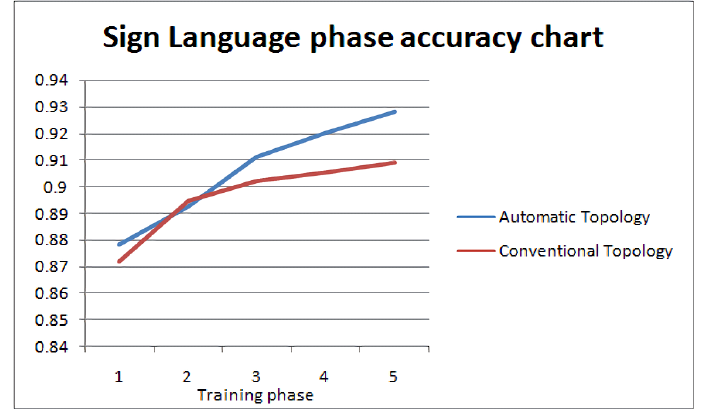
Figure 20. Sign Language accuracy progression.